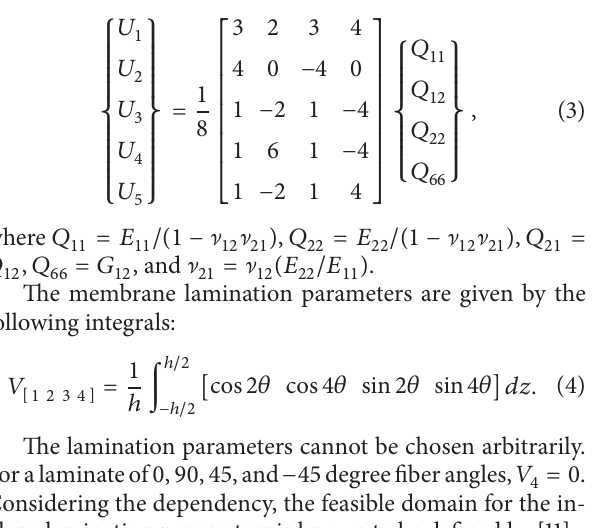
Table 1: Material property of